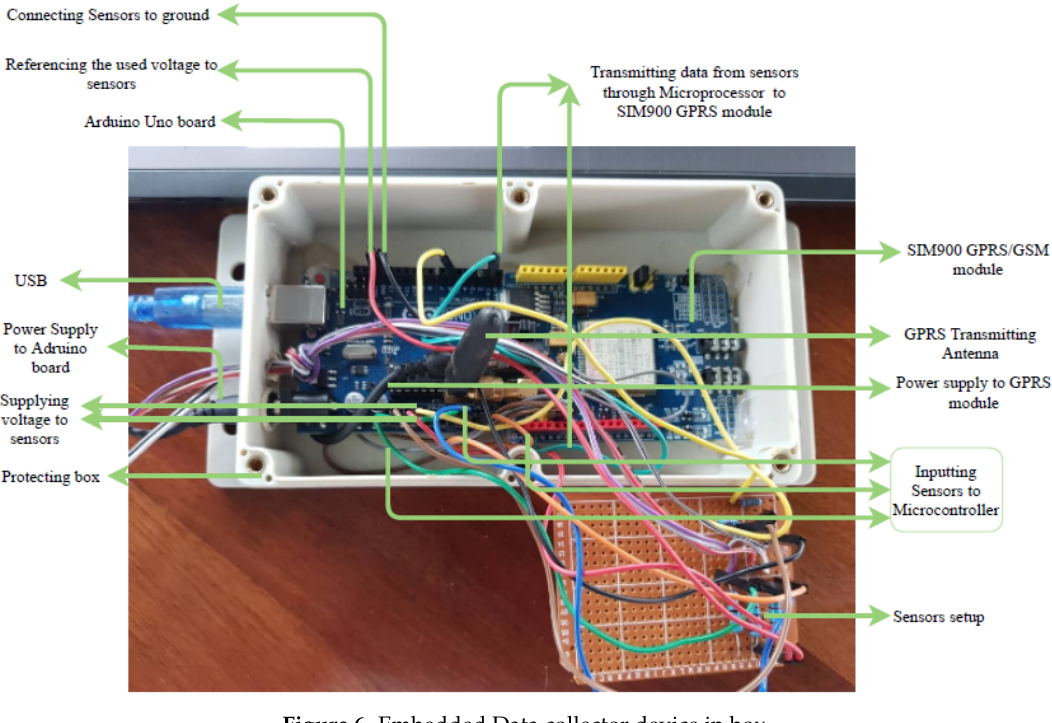
Figure 6. Embedded Data collector device in box.